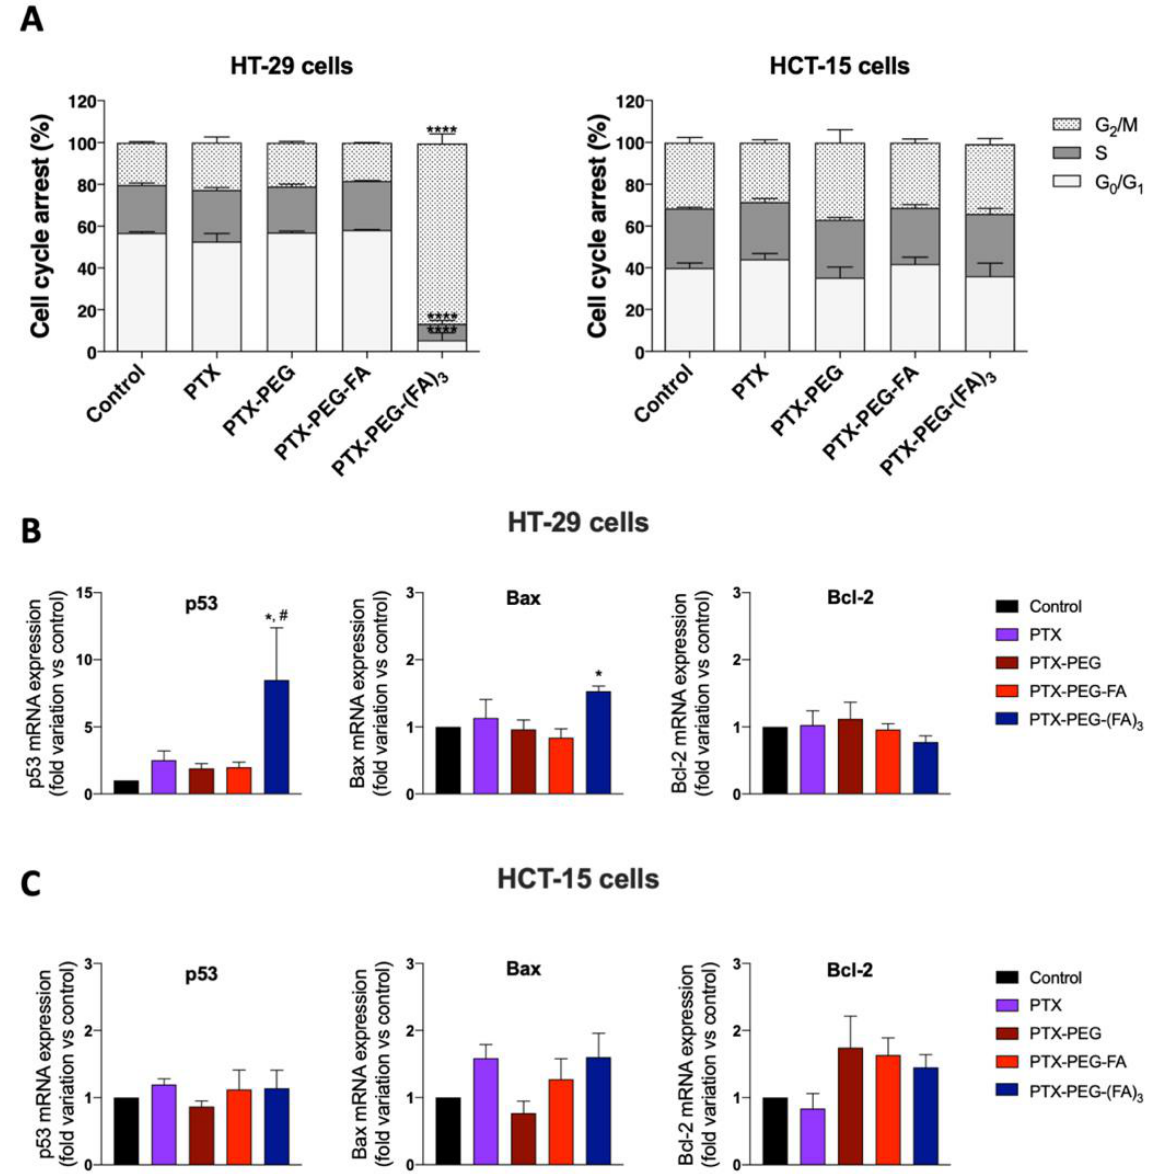
Figure 5. ( A ) Cell cycle distribution of HT-29 and HCT-15 cells exposed to PTX and PTX conjugates . **** p < 0.0001 vs. all the other treatments. Effect of PTX and PTX conjugates on the mRNA expression of the pro-apoptotic genes p53 and Bax, and the anti-apoptotic gene Bcl-2 on HT-29 ( B ) and HCT-15 ( C ) cells. * p < 0.05 vs. control, # p < 0.05 vs. cells treated with PTX. The results are the mean of three independent experiments, each performed in triplicate.